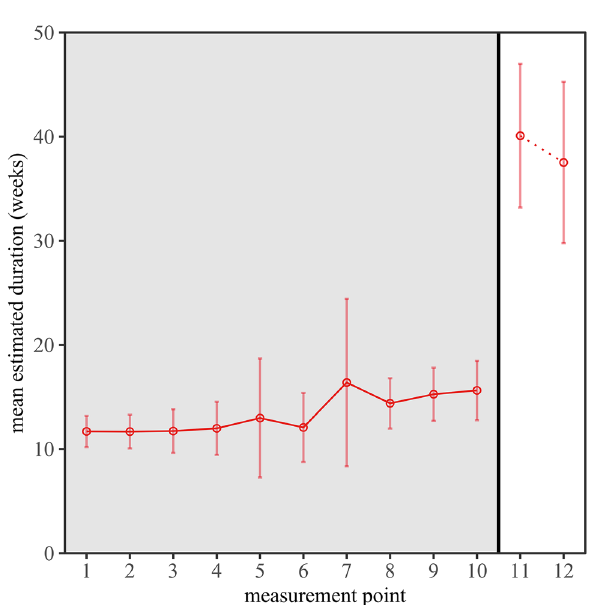
Figure 3. Mean estimated durations of how long respondents expected the pandemic to last as a function of measurement point. The main study included measurement points 1–10 (gray background). The follow-up study included measurement points 11 and 12 (white background). Error bars show 95% confidence